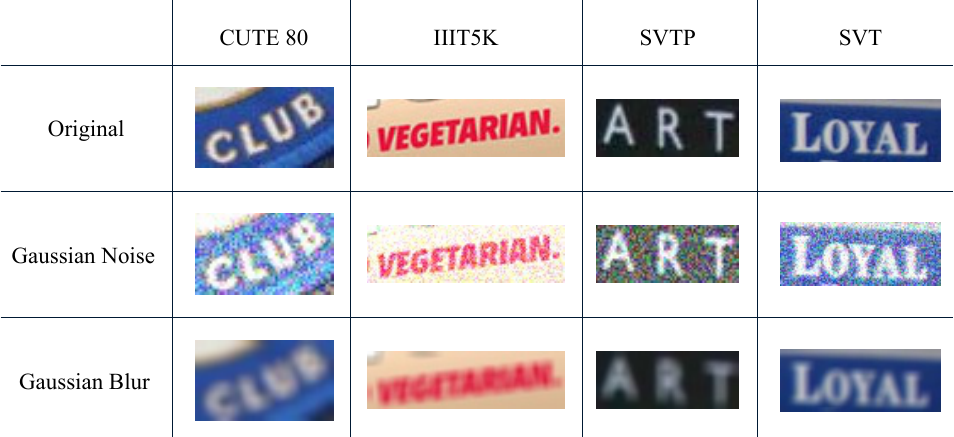
Figure 7. Sample images from the STR benchmarks processed by Gaussian blur and Gaussian noise. Gaussian noise of σ = 150 is added to the original image as noise processing, and a 3 × 3 Gaussian kernel is convolved with the original image as blurring processing.